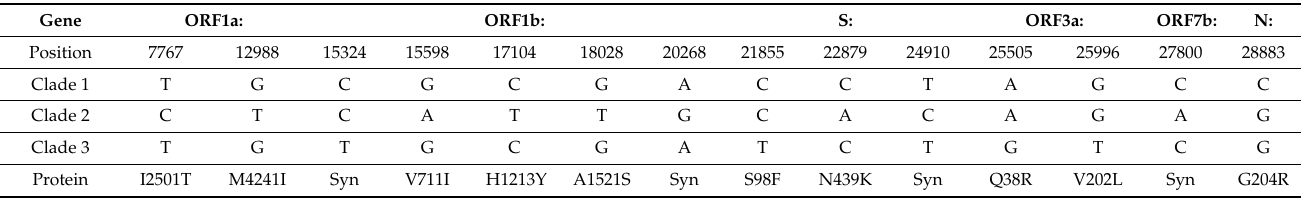
Figure 2. Maximum likelihood (ML) phylogeny of West Pomeranian SARS-CoV-2 whole-genome sequences (n = 122) . Branches of the three main clades are colored in blue, green, and orange. Specifically, the most common mutations in spike are highlighted: Δ H69/V70, Δ Y144, P681H, N439K, L18F, N501Y, S477N, A222V, A626S, S98F, and H655Y. Inner rings indicate the presence or absence of the deletion and amino acid variants. The multicolored outer ring shows virus variants in the West Pomeranian region together with the Wuhan reference sequence (red branch, GenBank accession no. MN908947.3). Virus variants were assigned in Nextstrain (and PANGO lineage) classification. Table 1. Clade-defining mutations in the analyzed dataset. Positions are listed according to the reference genome (MN908947.3). Syn—synonymous mutation.